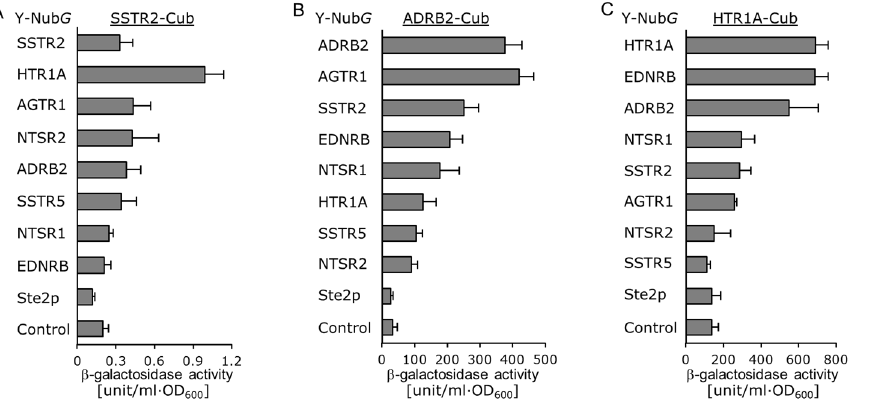
Figure 7. Quantitative b -galactosidase assays for homo- and hetero-dimerization between human-GPCRs in NMY63 strain. NMY63 yeast strain was transformed with GPCR-Nub G indicated at the left and SSTR2-Cub-LexA-VP16 (A), ADRB2-Cub-LexA-VP16 (B), or HTR1A-Cub-LexA- VP16 (C). The control prey plasmid was pPR3-C mock vector. Error bars represent the standard deviations ( n= 3).